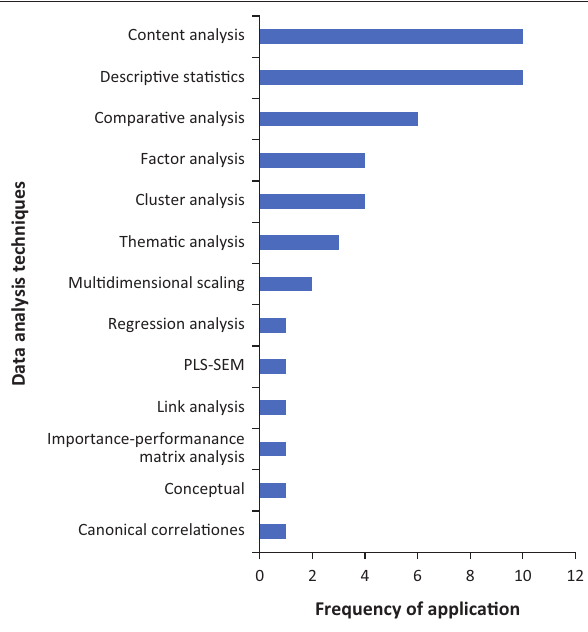
PLS-SEM, Partial least squares structural equation modelling. FIG URE 6: Data analysis techniques.